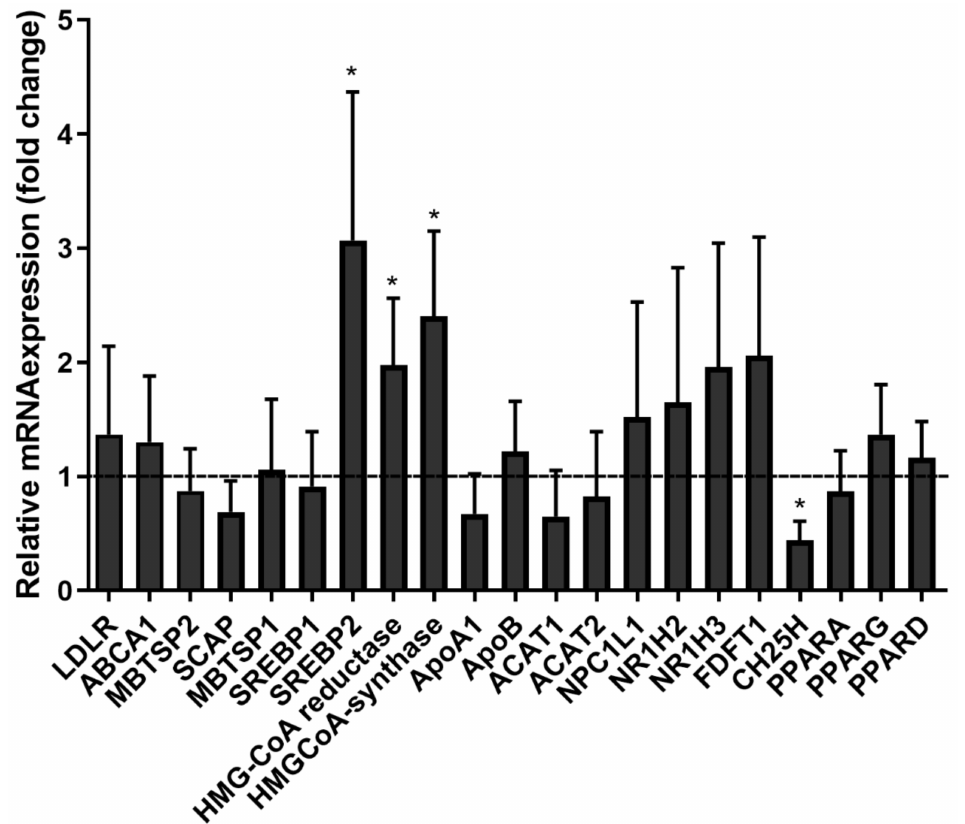
Figure 8. SARS-CoV-2pp entry into cells modulates the expression of genes involved in cholesterol biosynthesis. Huh7 cells were infected with SARS-CoV-2pp (35,000 RLU/mL) for 48 h. Infected cells and uninfected cells (control) were used for extraction of total RNA to measure the expression of various genes by qRT-PCR. Values are plotted as the mean ± SD of three independent experiments. p values were calculated using a two-tailed Student t -test. *, p < 0.05. Abbreviations: LDLR,